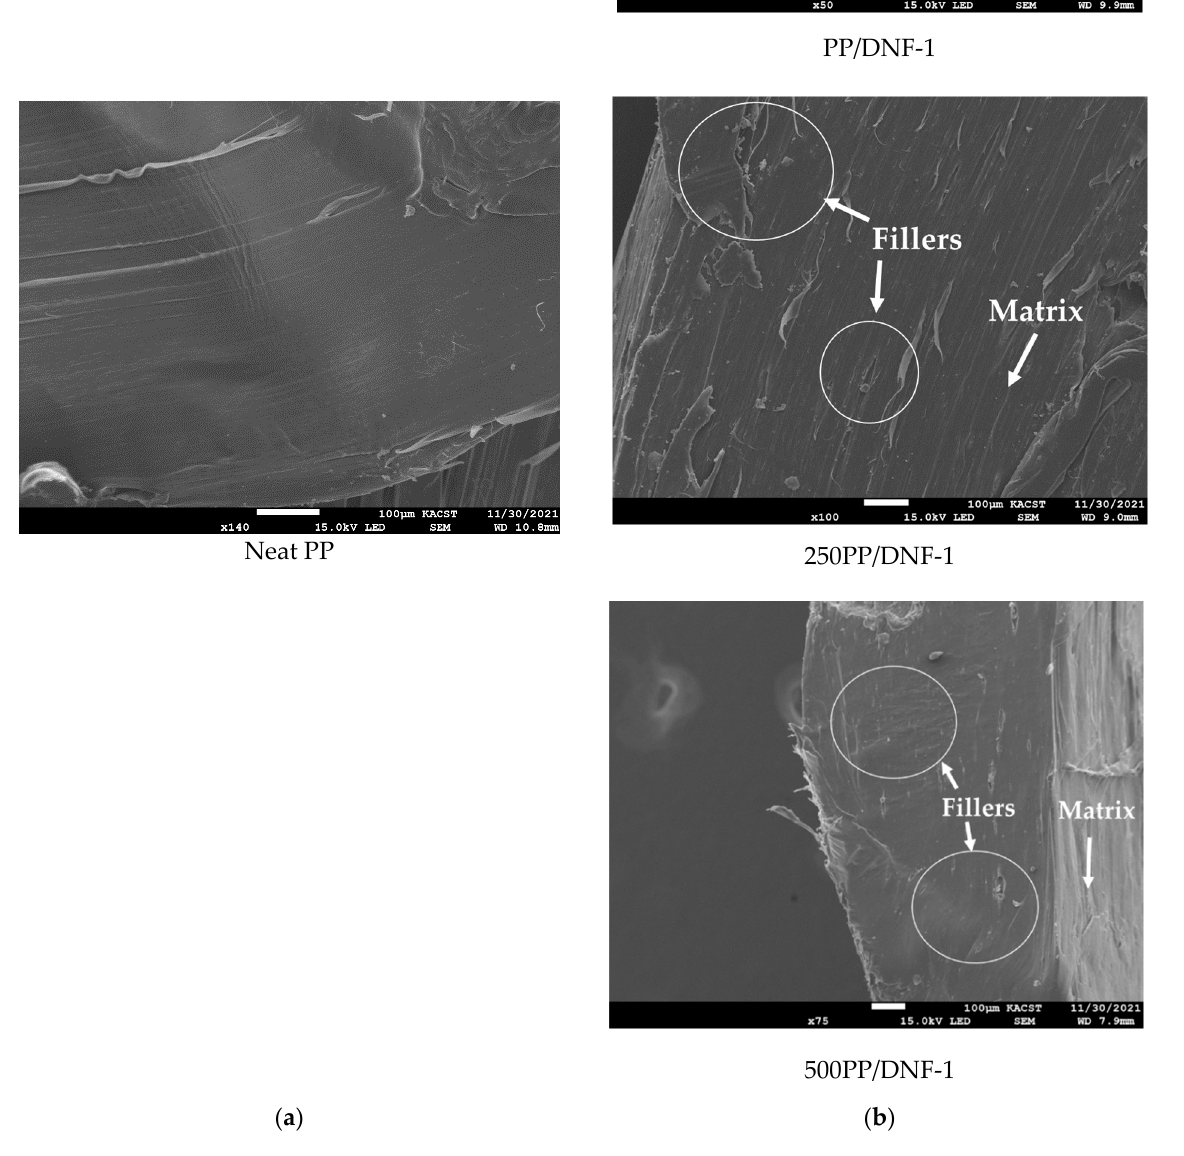
Figure 7. Representative SEM images of the cryo-fracture surface of ( a ) PP, ( b ) PP/DNF-1, 250PP/DNF-1, and 500PP/DNF-1.